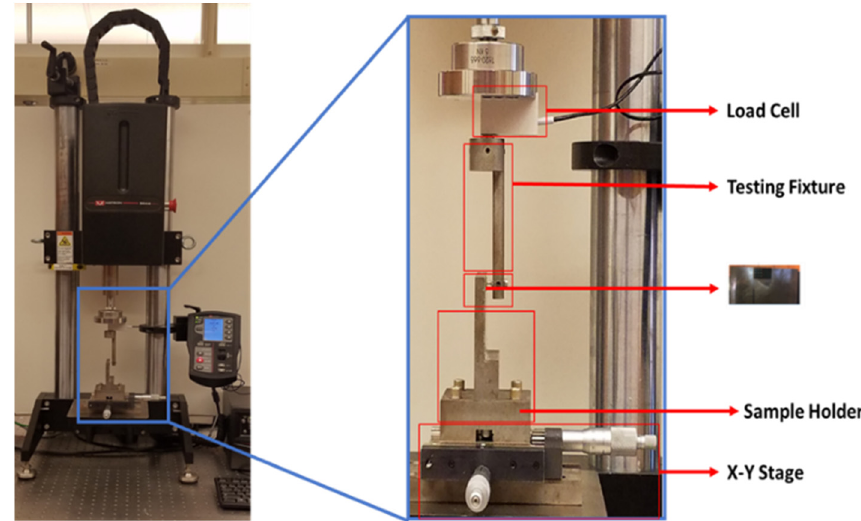
Figure 3. The Instron 5948 Micro-Tester.